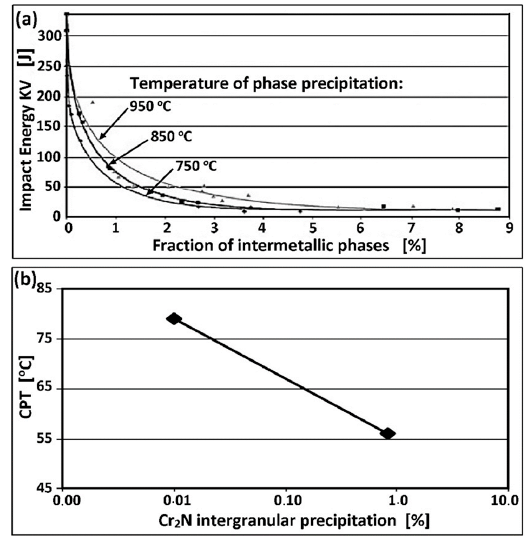
Figure 8. Changes in the microstructure lowering ductility and corrosion resistance of duplex steels, including ( a ) breaking energy KV as a function of intermetallic phase content in duplex steels (according to [37]), ( b ) CPT (Critical Pitting Temperature) index as a function of the content of intercrystalline Cr 2 N precipitates (according to